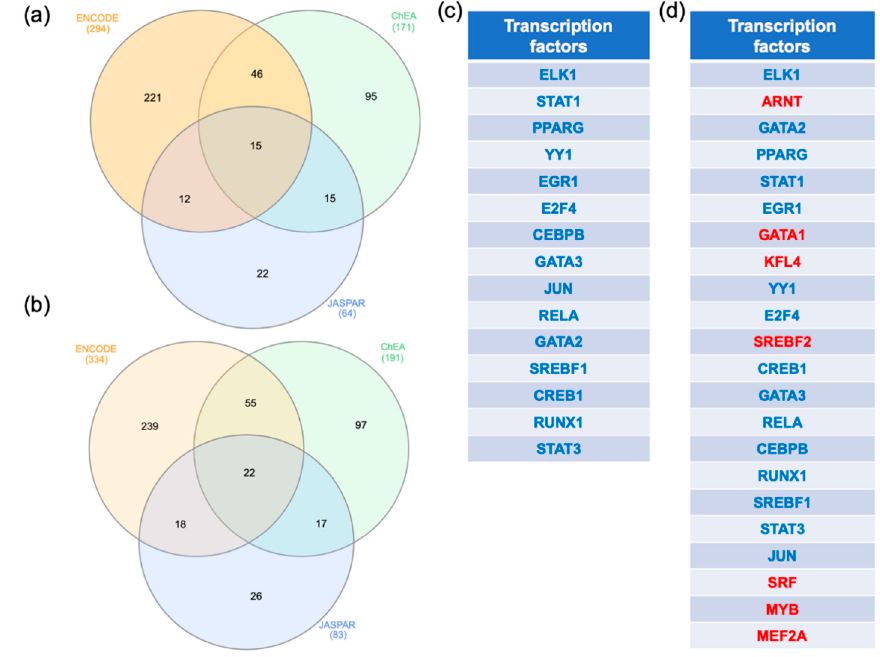
Figure 4. Transcription factors analysis. The genes commonly dysregulated in the MCI arrays and in at least two out of the ADD arrays were obtained using Venn diagram analysis. The gene lists were uploaded to https://www.networkanalyst.ca/NetworkAnalyst/faces/home.xhtml. The gene-transcription factor interaction network was performed with ENCODE, ChEA, and JASPAR. A Venn diagram analysis was performed to identify the transcription factors identified by the three methods. ( a , b ) represent the results of the Venn diagram analysis performed with MCI and ADD genes, respectively. The transcription factors interacting with the MCI and ADD genes were listed in ( c , d ), respectively. Transcription factors in blue are common in MCI and ADD analysis whereas the transcription factors in red were specific to ADD regulation.